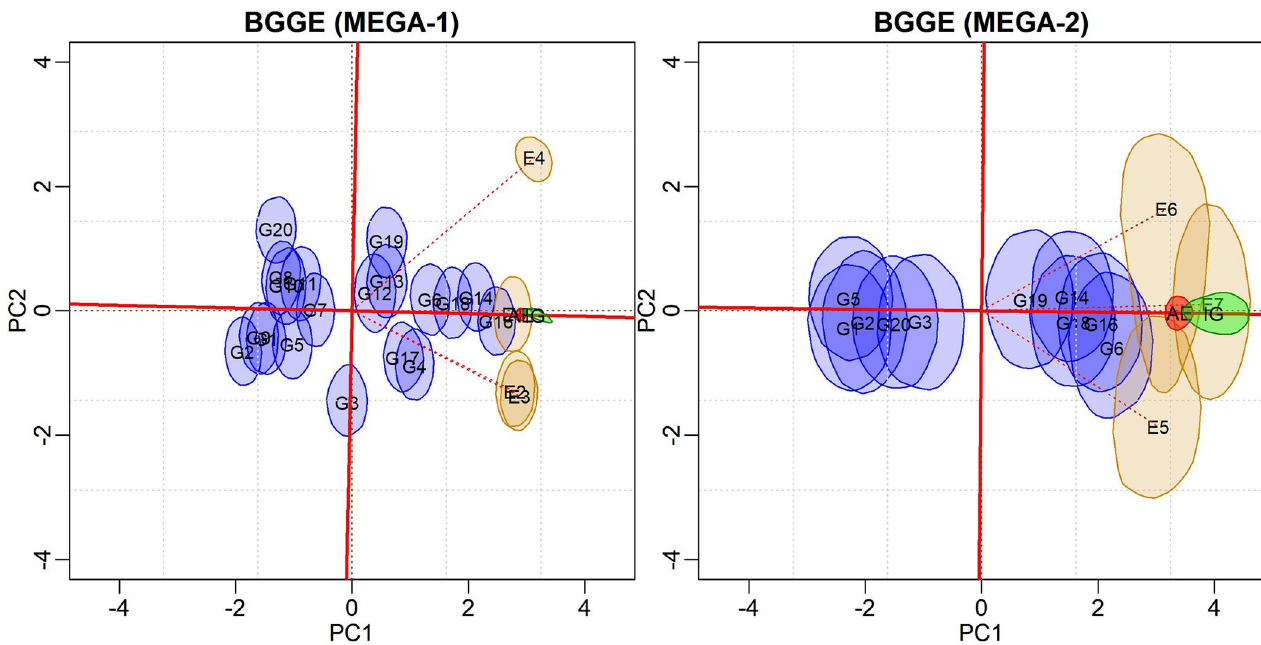
Fig 4. Biplot for the BGGE (Bayesian-GGE) model with 95% credible regions, including the genotypic and environmental scores for the average environment (red) and ideal genotype (green) for the two defined mega-environments. https://doi.org/10.1371/journal.pone.0256882.g004 PLOS ONE | https://doi.org/10.1371/journal.pone.0256882 August 30,